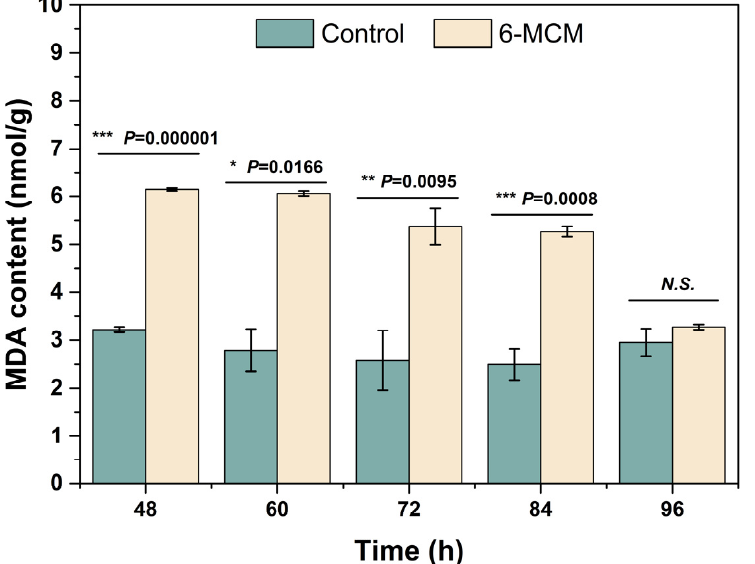
Figure 5. Effect of 6-methylcoumarin on V. mali cell membrane lipid peroxidation. V. mali was cultured in the PDB containing 10% Tween-80 (as a control) and 105 mg/L 6-methylcoumarin solution, respectively. The bars represent the standard error of the mean (n = 3), and the asterisks indicate that significant differences exist between 6-MCM treatment and control using an independent-sample t -test. N.S., no significance. 6-MCM, 6 ‐ methylcoumarin.